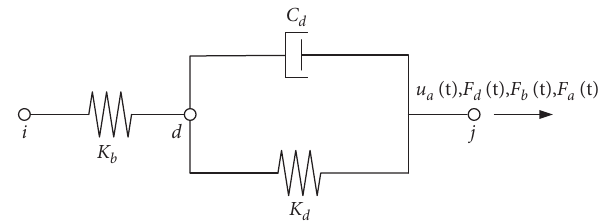
Figure 1: Mechanical Model of the VED-brace